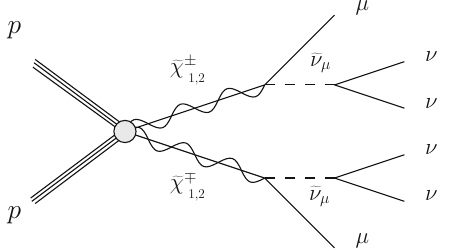
Fig. 3 Production of a chargino pair, each decaying to a LH muon- sneutrino, which in turn decays to neutrinos, giving rise to the signal 2 μ +